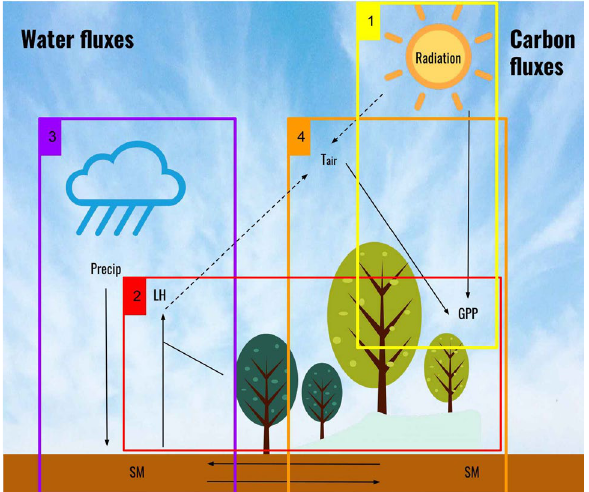
Figure 1. The causal dissection of the coupled carbon-water fluxes in the Earth system. Boxes indicate the variable relations studied in this paper with the proposed causal inference methodology. Dashed arrows are only implicitly considered in this